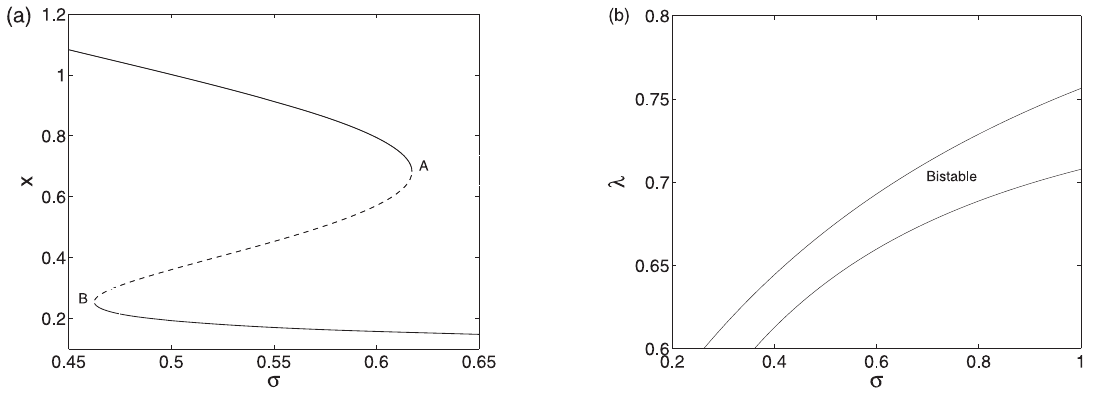
Figure 2. Bifurcation diagrams of model I. (a) The bifurcation diagram with s as a control parameter. (b) The codimension two bifurcation diagram with s and l as control parameters. Other parameter values are l ~ 0 : 6 , d ~ 0 : 5 , c ~ 0 : 2 , a ~ 2 , m ~ 0 : 5 , b ~ 0 : 2 , and r ~ 40 .